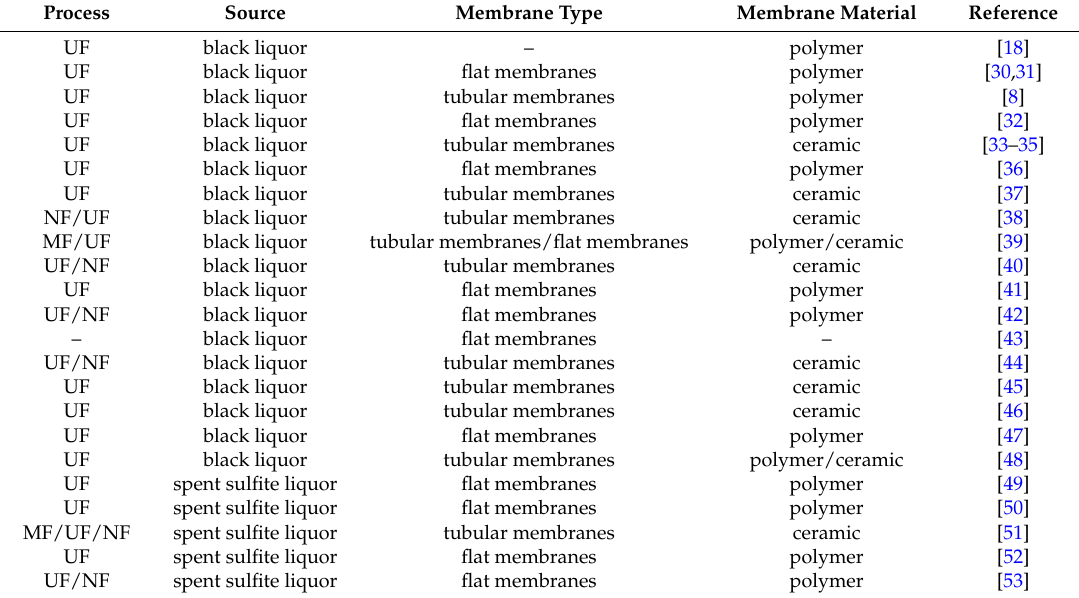
Table 3. Overview of recent studies investigating membrane technologies for the treatment of black liquor and spent sulfite liquor from pulp and paper